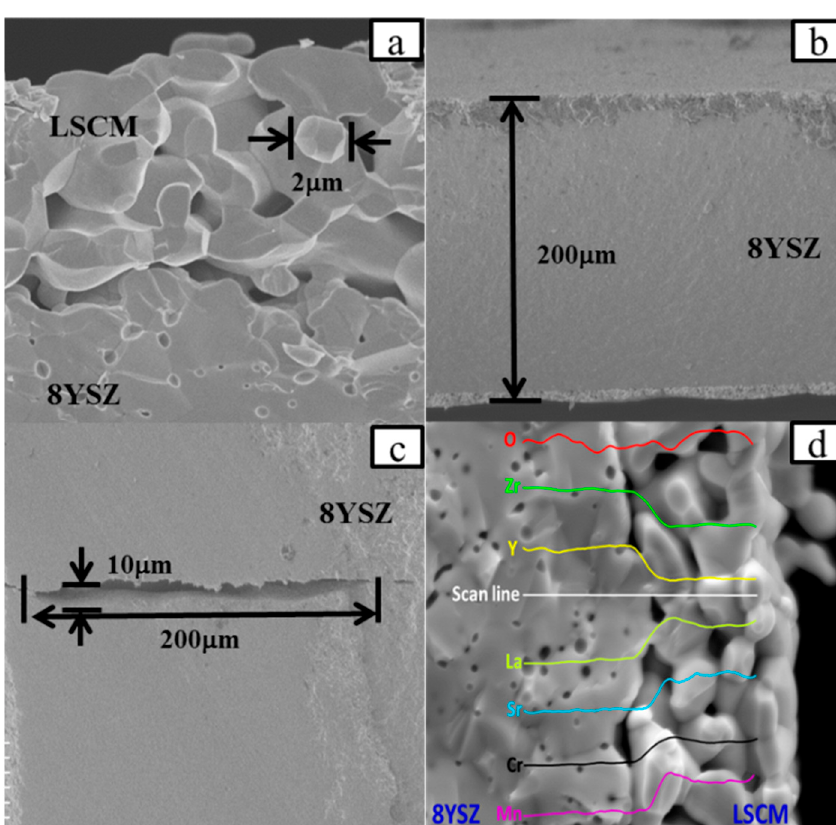
Figure 3. Scanning electron microscopy (SEM) images of ( a ) LSCM powder calcined at 1100 °C; ( b ) Micro-structure of LSCM electrode after 1400 °C co-firing with 8YSZ; ( c ) Diffusion barrier of sensor; and, ( d ) Energy Disperse Spectroscopy (EDS) image at line scan mode.